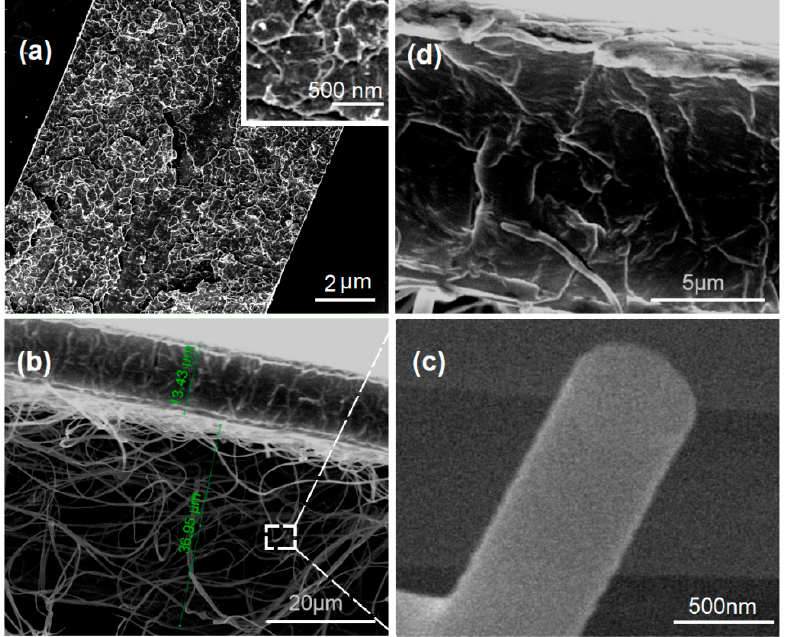
Figure 5. The SEM cross-sections of products: ( a ) casting film F8; ( b ) the DHFs of F9; ( c ) an enlarged image of a nanofiber’s cross-section; ( d ) an enlarged image of the casting film section of DHFs F9.